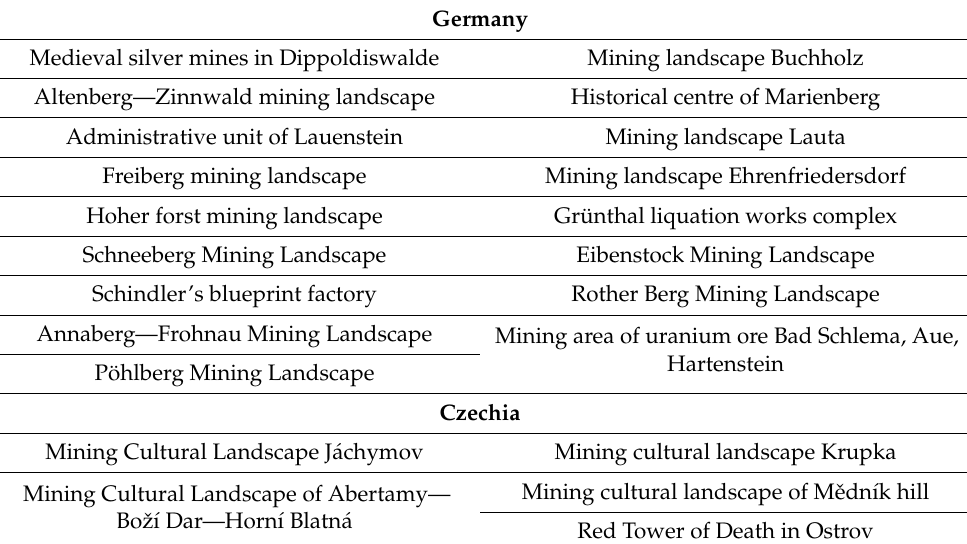
Table 1. Components of the Mining Cultural Landscapes of the Krušnohoˇr í /Erzgebirge inscribed on the UNESCO World Heritage